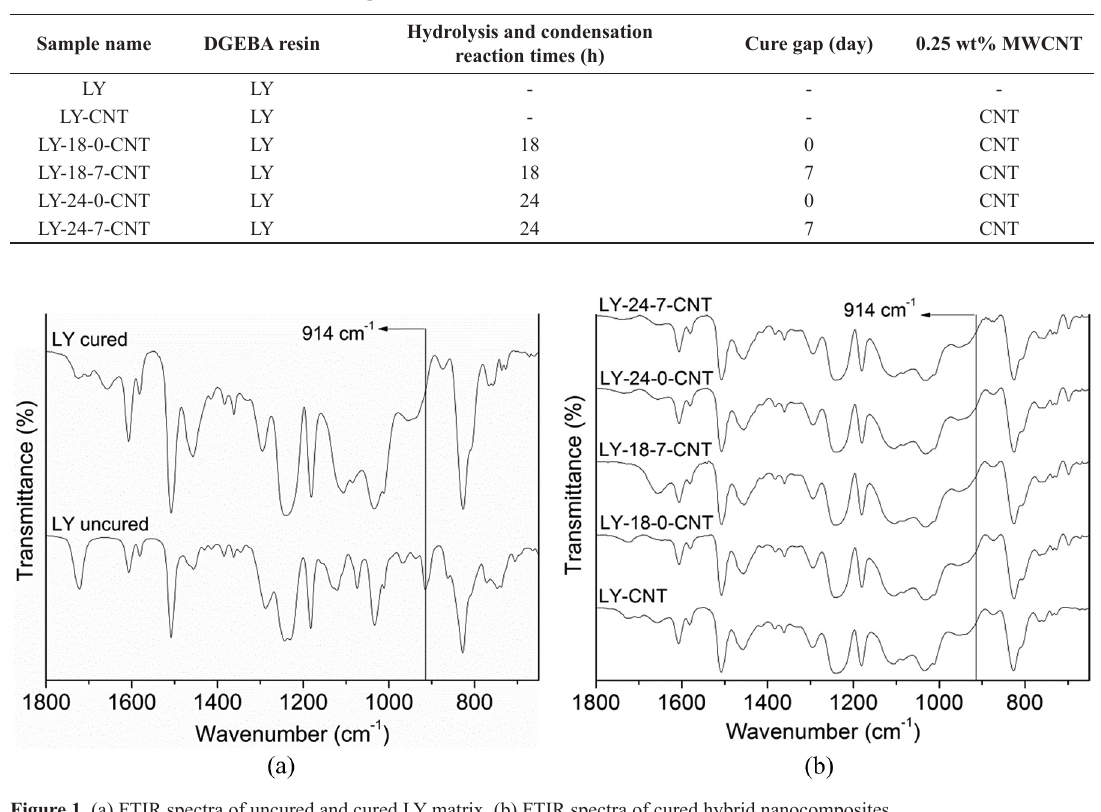
Figure 1. (a) FTIR spectra of uncured and cured LY matrix. (b) FTIR spectra of cured hybrid